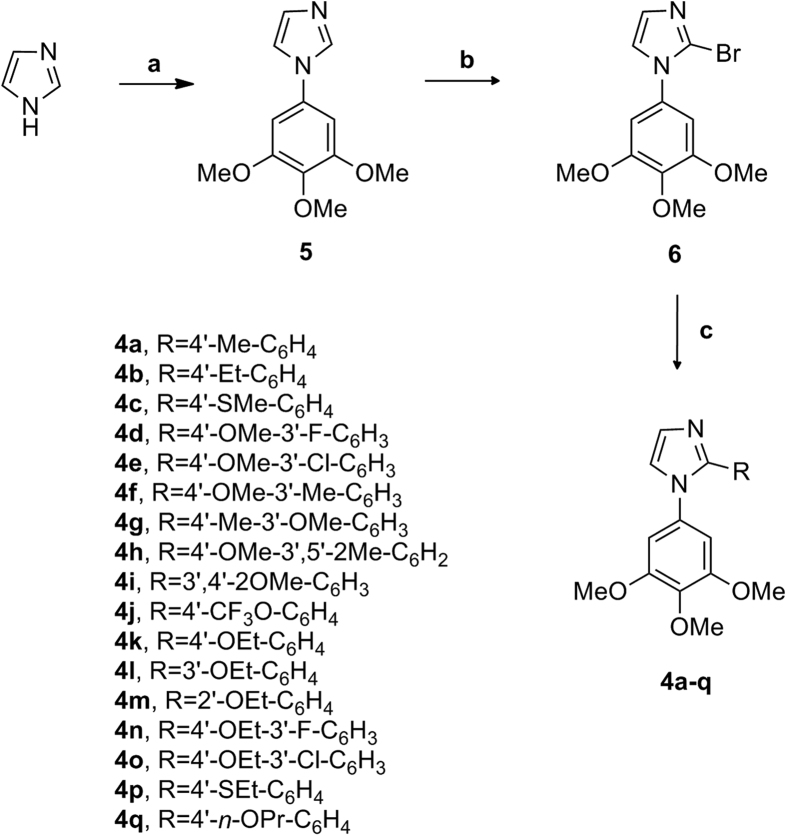
General synthetic procedure followed for the preparation of compounds 4a–q.Reagents. (a) 1-bromo-3,4,5-trimethoxybenzene, Cs2CO3, CuI, DMF, 120 °C, 40 h; (b) NBS, CH3CN, rx; (c) PdCl2(DPPF), ArB(OH)2, CsF, 1,4-dioxane, 65 °C.